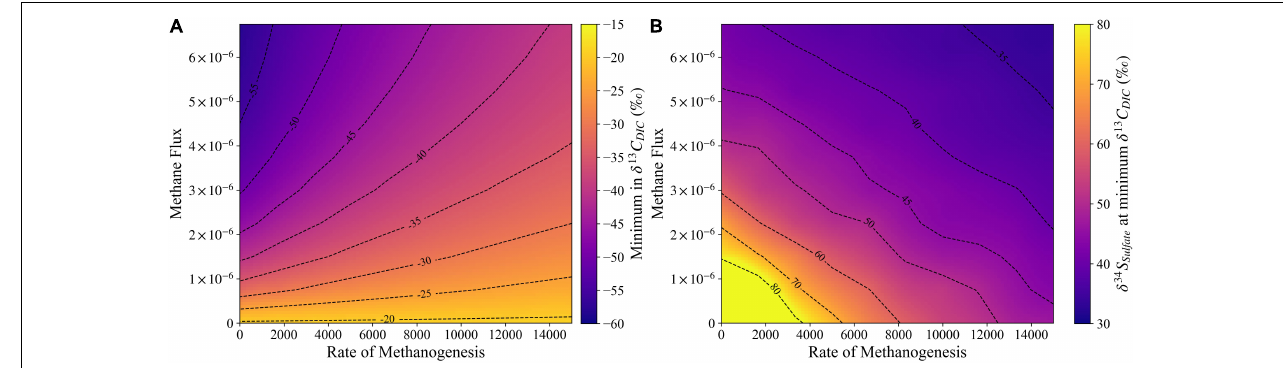
FIGURE 9 | Contour plots displaying the impact of the rate of methanogenesis and methane flux on the minimum δ 13 C value (A) and the associated δ 34 S value (B) .